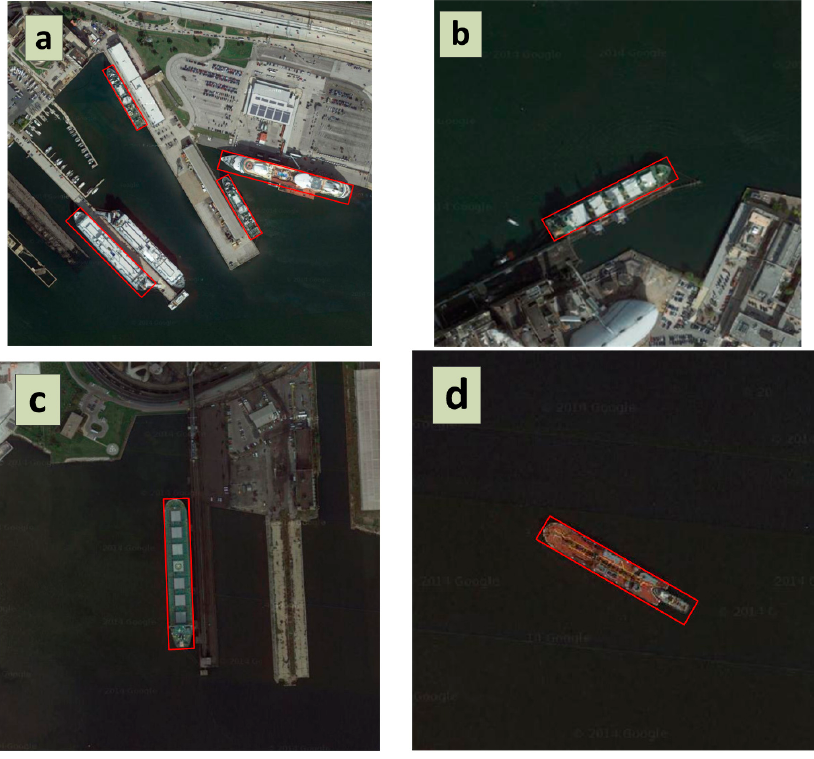
Figure 7. Detection results of the proposed method. Table 1. Detection Results of Different